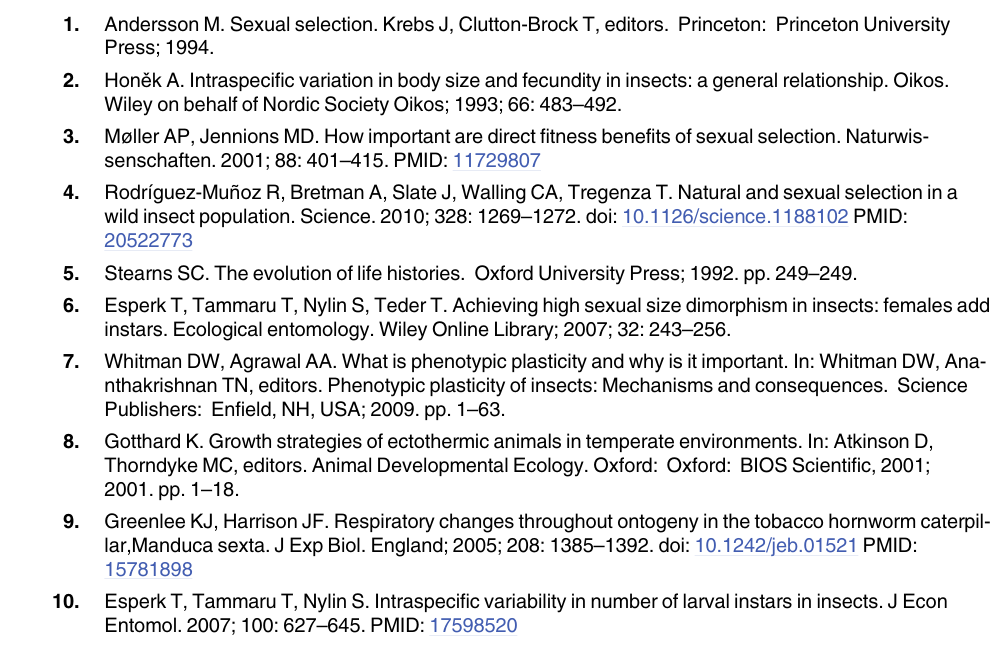
S1 Table. Factors influencing nymphal development in S . gregaria , for all models, includ- ing those displaying a Δ AIC < 2. For each trait, selected variables came from linear models displaying a Δ AIC < 2, among all possible models including a null model and a full model (i.e., containing all variables as well as every simple interaction between pairs of variables; see Meth- ods). Note that for extra molting and for growth rate we used GLMs with logit link function and linear mixed model, respectively. We report estimates, standard deviations, t values (except for extra molting; #: z values) and P -values associated with each variable (and intercepts). For growth rate, L2, L3, L4 and L5 refer to 2nd to 5th nymphal instars. L3b refers to the added nymphal instar for individuals undergoing extra molting. Gray areas emphasize the outcome of models displaying the lowest AIC values. (cid:2)(cid:2)(cid:2) < 0.001 < (cid:2)(cid:2) < 0.01 < (cid:2) < 0.05 < . < 0.1